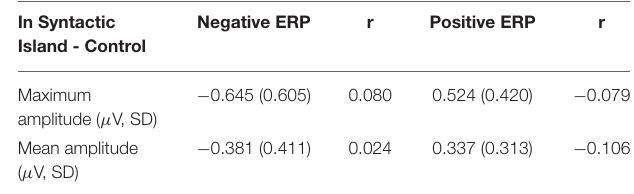
TABLE 4 | Means of the mean amplitudes and the maximum amplitudes for the ERPs at subordinate verbs in In Syntactic Island for Quantifier First.